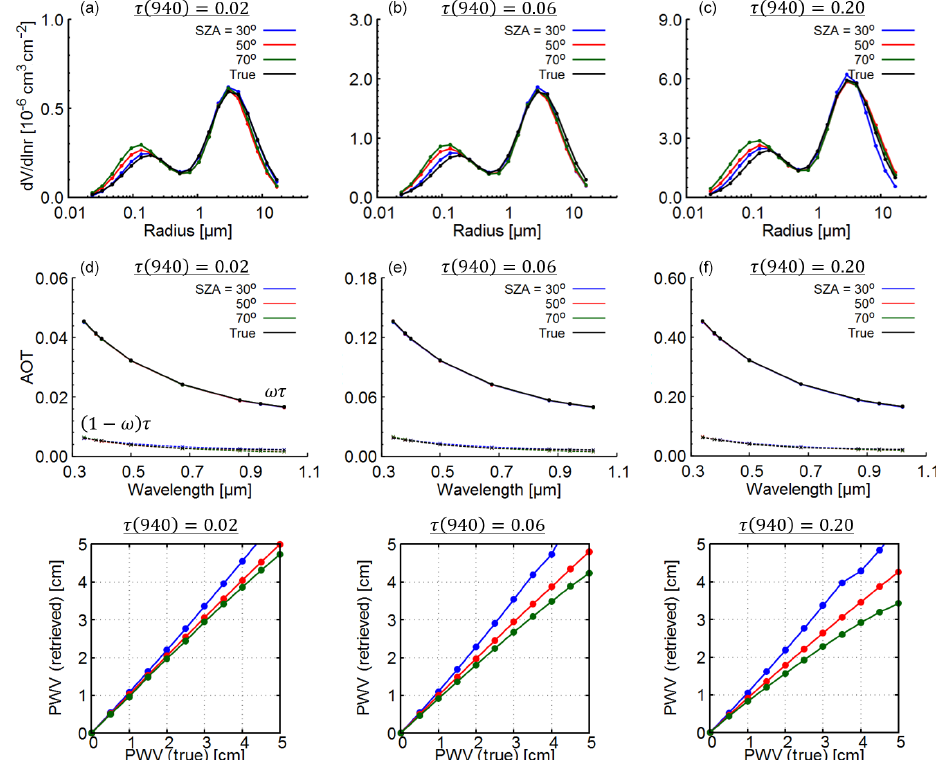
Figure 12. Similar to Fig. 11 but for transported-dust aerosol. Note that the blue, red, green, and black lines in the middle row